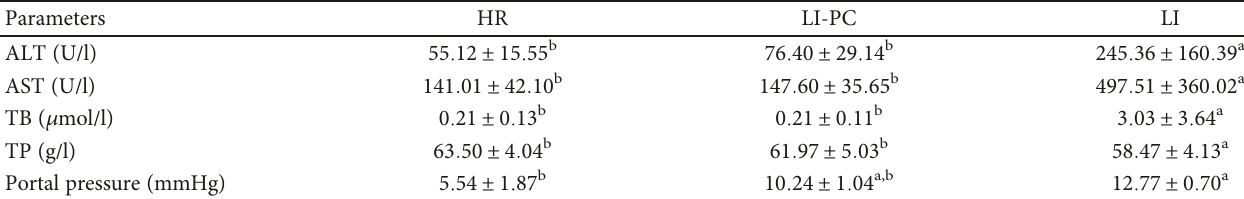
Table 1: Comparison of liver function and the value of portal pressure among the experimental groups. Parameters